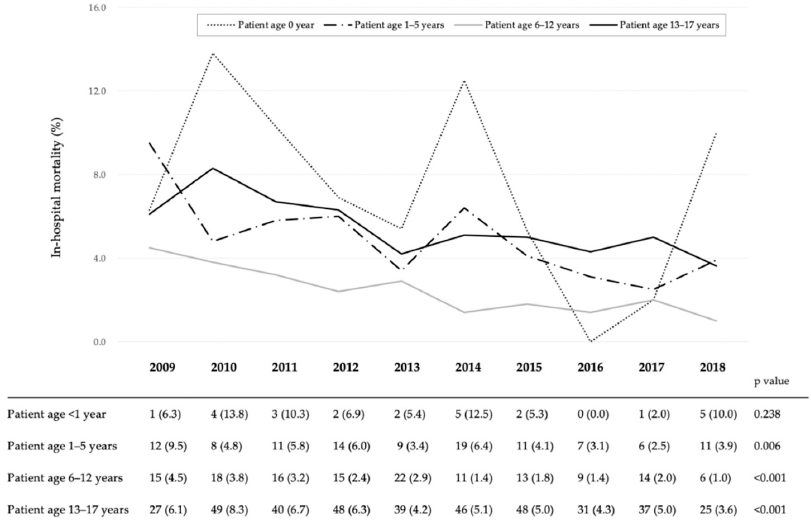
OR, odds ratio; CI, confidence interval; TRISS, Trauma and Injury Severity Score; Ps, probability of survival.